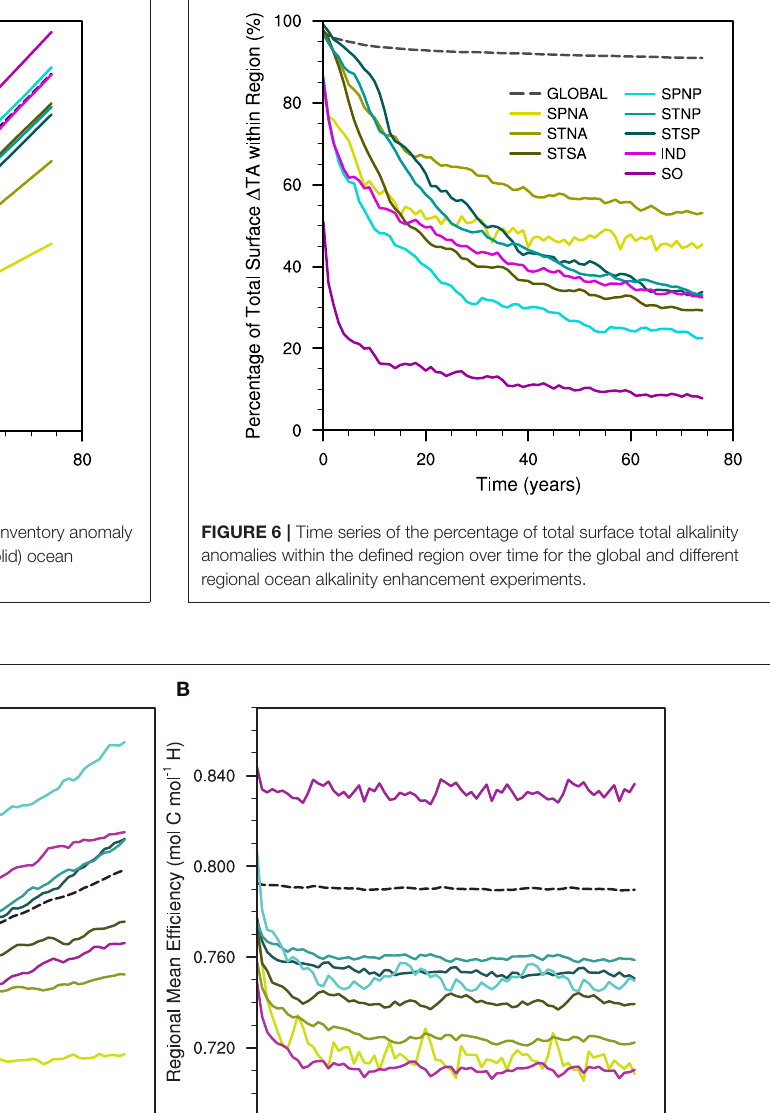
Frontiers in Climate |